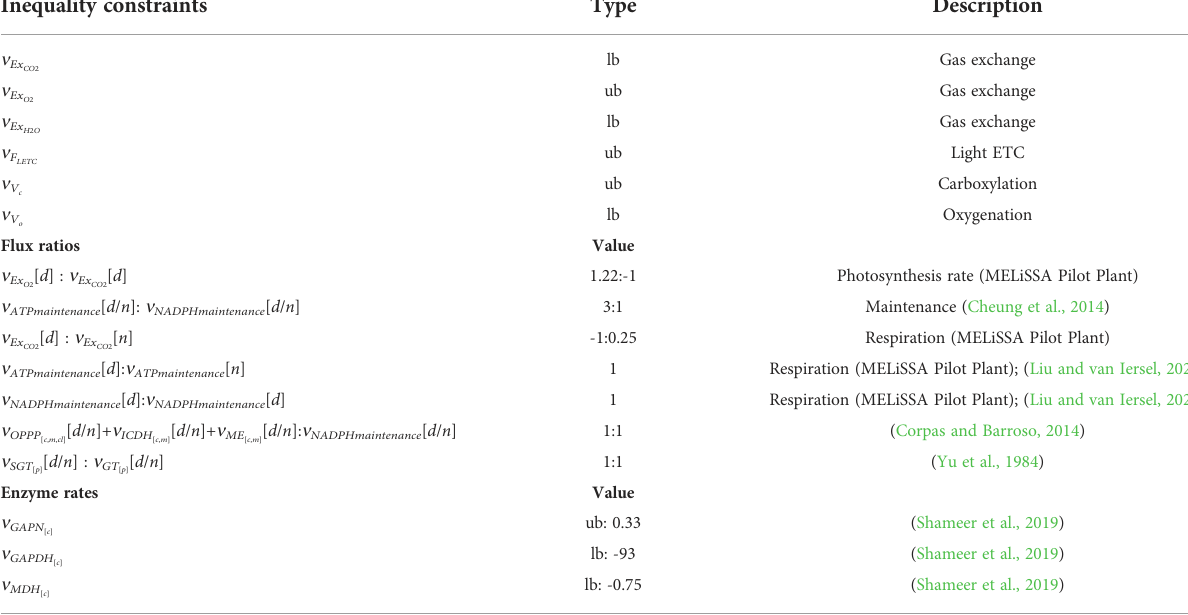
*NADPH oxidation and ATP hydrolysis associated with maintenance reactions include plastidic, cytoplasmic, and mitochondrial locations. Subscripts c , m , cl , and p indicate cytoplasmic, mitochondrial, plastidic, and peroxisomal location. lb and ub represent lower and upper bounds, respectively. List of enzyme abbreviations: GAPN, cytosolic non-phosphorylating NADP-glyceraldehyde-3-phosphate dehydrogenase; GAPDH, cytosolic glyceraldehyde 3-phosphate dehydrogenase; MDH, cytosolic malate dehydrogenase; OPPP, glucose-6-phosphate dehydrogenase and 6-phosphogluconate dehydrogenase; ICDH, isocitrate dehydrogenase; MDH, malate dehydrogenase; SGT, serine- glyoxylate aminotransferase; GT, glutamate-glyoxylate